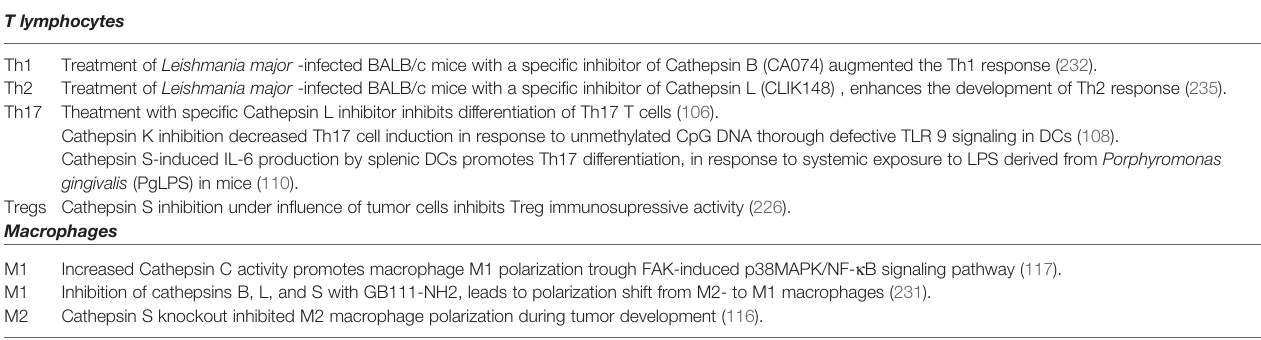
TABLE 2 | The effects of cysteine cathepsin activity modulation on immune cell subset differentiation. T lymphocytes Th1 Treatment of Leishmania major -infected BALB/c mice with a speci fi c inhibitor of Cathepsin B (CA074) augmented the Th1 response (232). Th2 Treatment of Leishmania major -infected BALB/c mice with a speci fi c inhibitor of Cathepsin L (CLIK148) , enhances the development of Th2 response (235). Th17 Theatment with speci fi c Cathepsin L inhibitor inhibits differentiation of Th17 T cells (106). Cathepsin K inhibition decreased Th17 cell induction in response to unmethylated CpG DNA thorough defective TLR 9 signaling in DCs (108). Cathepsin S-induced IL-6 production by splenic DCs promotes Th17 differentiation, in response to systemic exposure to LPS derived from